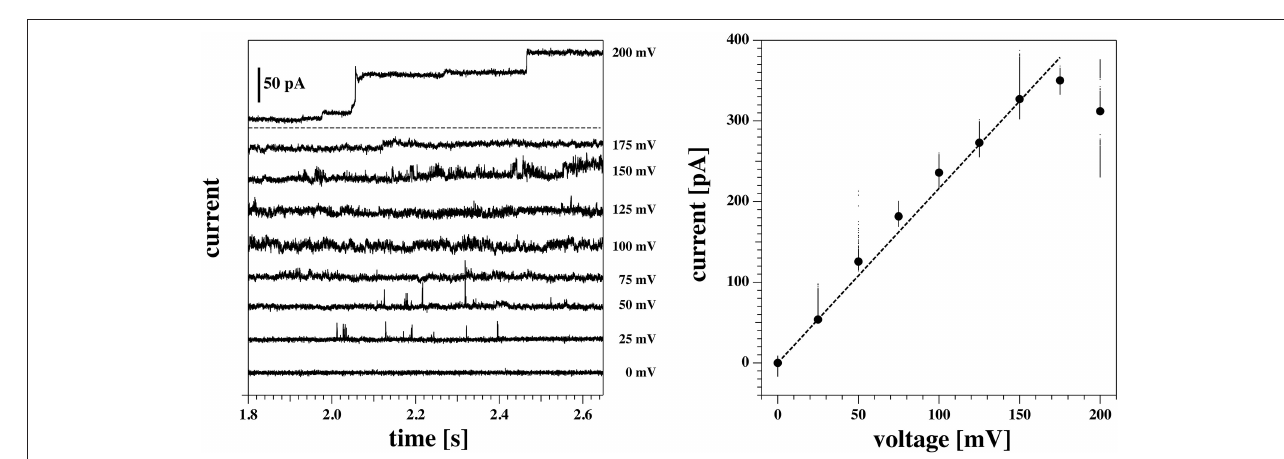
FIGURE 10 | Current response of the same membrane as Figures 6 , 7 (membrane 1) at a depth of 10 mm below the water surface. The membrane ruptured at 0 mV. Hence only the positive range is shown. (Left) Current traces at different voltages. The top trace is the response to the first jump of the protocol (from 0 to 200 mV), and it has been plotted separately for clarity. At this voltage, the membrane shows a step-wise increase in conductance, from an initial value of about 1.2 nS to a final one of roughly 1.8 nS. In the bottom panel, the other traces are shown. Current fluctuations start to appear in the form of spikes already at 50 mV, and increase in number and duration at higher voltages. (Right) Current-voltage relationship for the traces shown at the left. A linear fit gives a value of the conductance of 1.8 nS. This is in line with the final value of conductance for the trace at 200 mV. Due to its transient behavior, however, this trace has not been included in the fit.